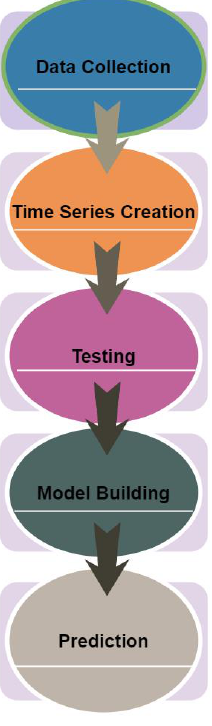
Figure 1. Time series data mining